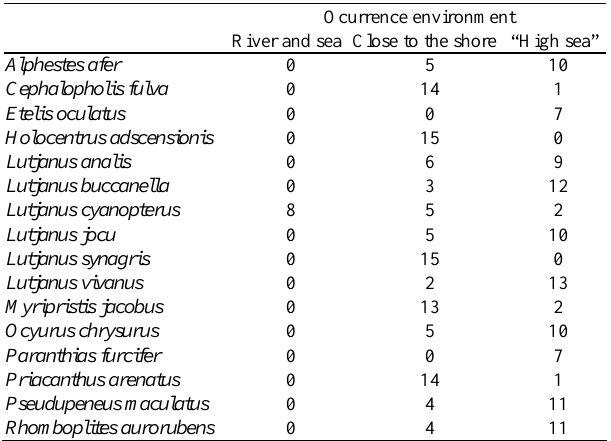
Table 4. Occurence environment mentioned for the snapper group according to interviewees with the respective number of obtained answers (number of interviews = 15; for the E . oculatus and P . furcifer n =